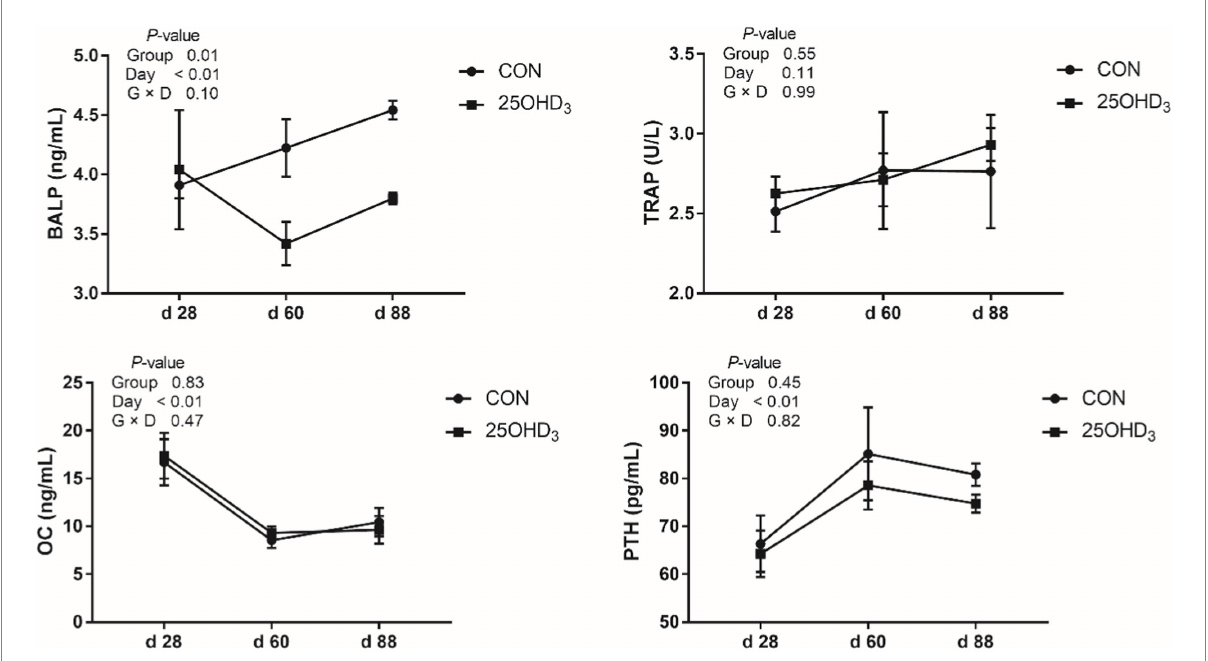
FIGURE 2 The serum bone biochemical markers between the two treatments. Values are shown as the means ± SEM, n = 5. BALP, bone-specific alkaline phosphatase; TRAP, tartrate-resistant acid phosphatase; OC, osteocalcin; PTH, parathyroid hormone.